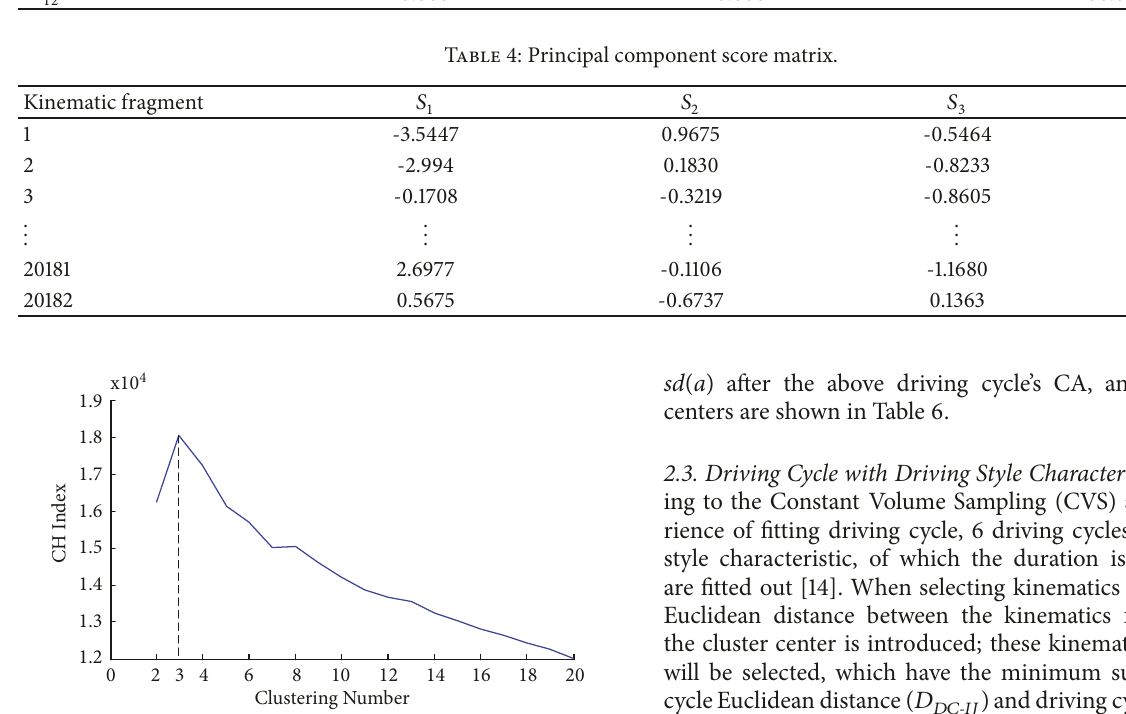
Figure 4: CH index of different clustering